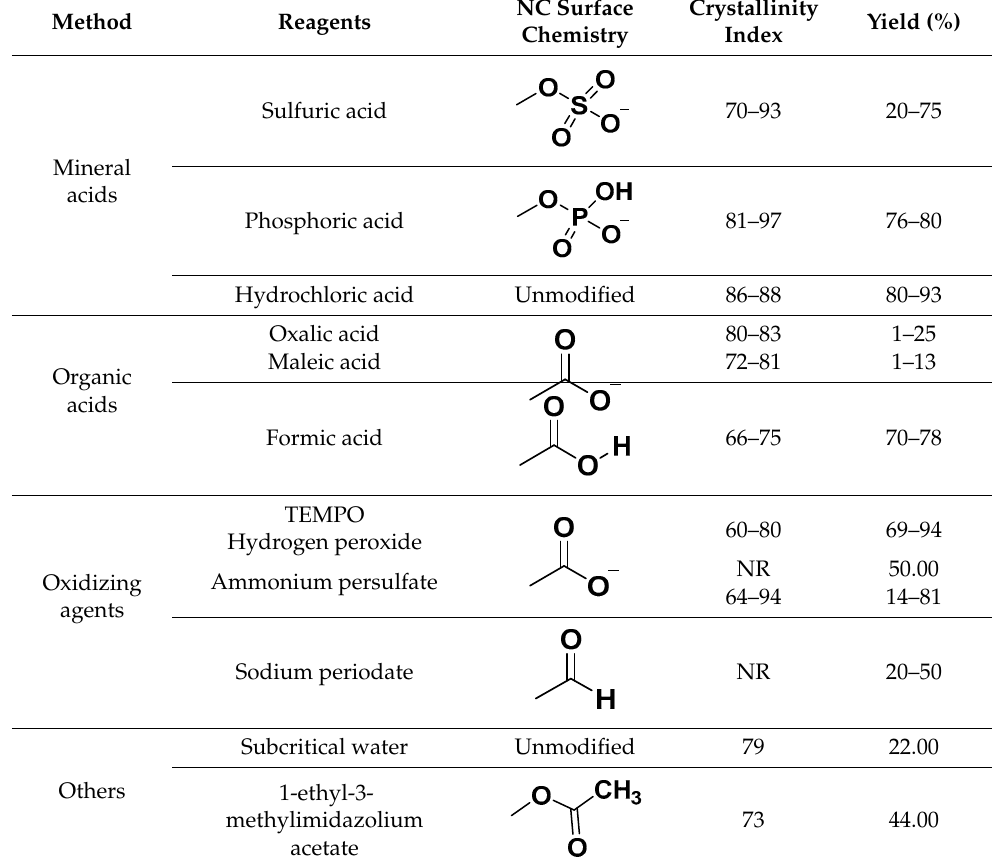
Table 1. Common production method of cellulose nanomaterial, TEMPO-(2,2,6,6-tetramethylpiper- idin-1-yl) oxyl.